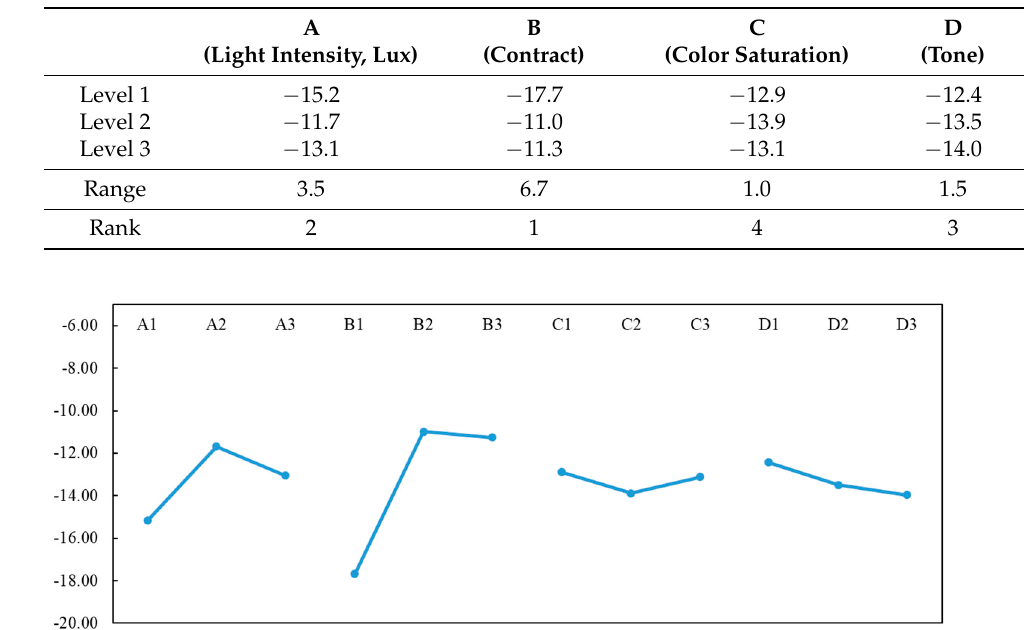
Figure 5. S / N response table for the four control factors of interest, where A is light intensity, B contrast, C color saturation, and D tone.